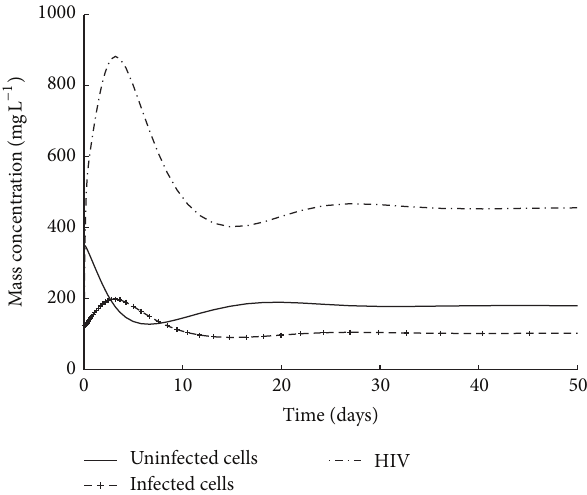
Figure 1: Open-loop behavior of the HIV